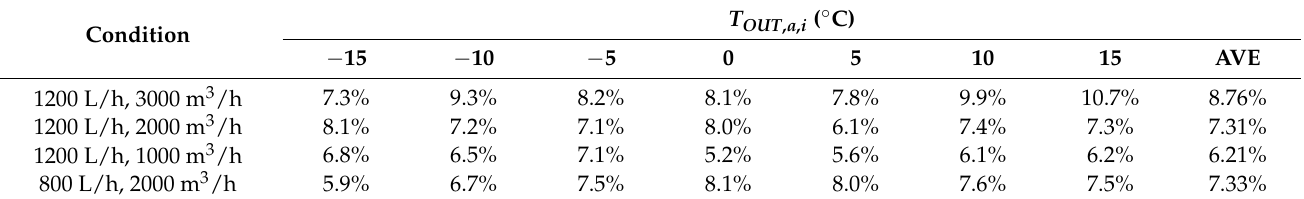
Figure 7. Heat loss percentage and heat transfer rate under different conditions. Table 4. Heat loss percentage Δ β under different conditions.